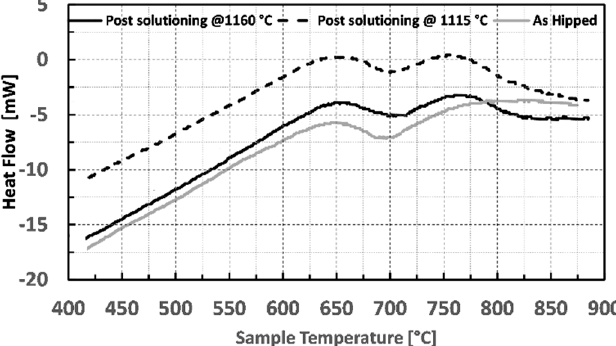
Figure 3. Di ff erential Scanning Calorimetry (DSC) analysis for Astroloy in the as HIPped condition (gray line), after solutioning at 1160 ◦ C (solid black line) and after solutioning at 1115 ◦ C (dotted black